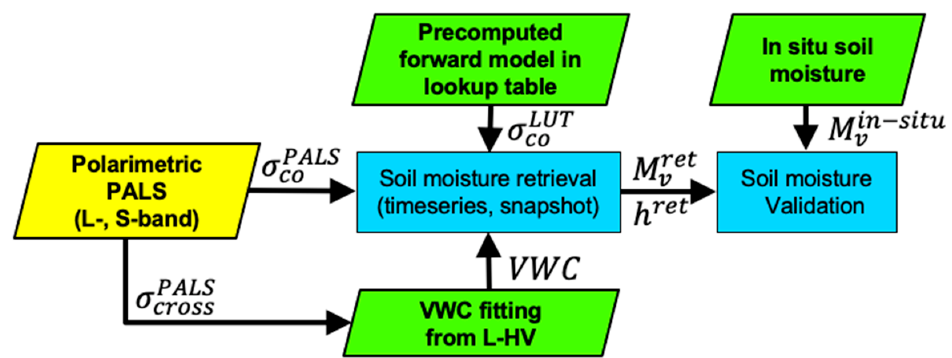
Figure 2. Soil moisture retrieval and validation flow chart. VWC stands for vegetation water content; LUT for lookup table.